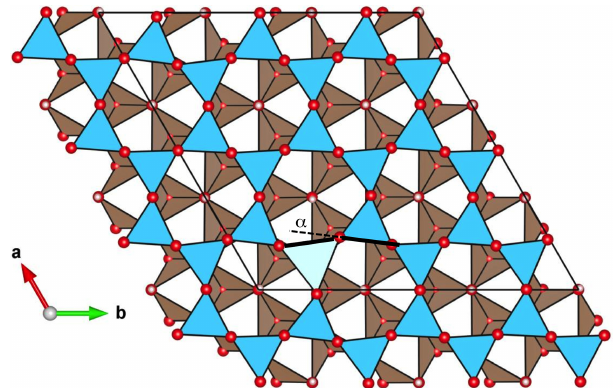
Figure 3. View of the structure of the (Fe 3 + ) T model along the [001] direction. Blue triangle: basal face of silicate tetrahedra; light blue triangle: basal face of the substituted site; red: oxygen atoms; light pink: H atoms; white and brown: faces of the MgO 6 octahedra. The presence of the substituting cation induces a rotation of the tetrahedra moving the basal oxygens away from the octahedral sites, which corresponds to a local increase in the absolute value of the α angle. Structure drawing made with the VESTA software (Momma and Izumi, 2011).